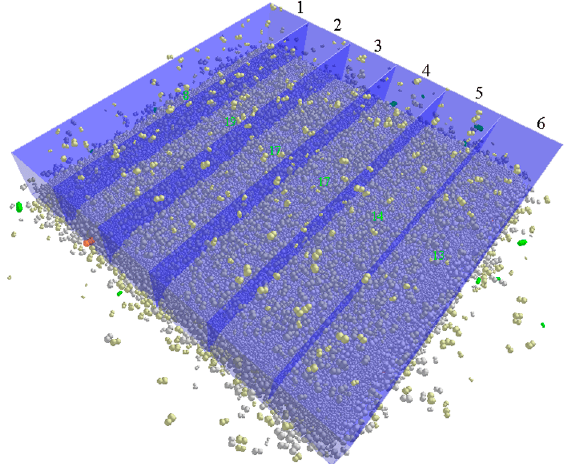
Figure 8. Six equally spaced grids in the longitudinal direction (perpendicular to the advancing direction of the machine) are set up.